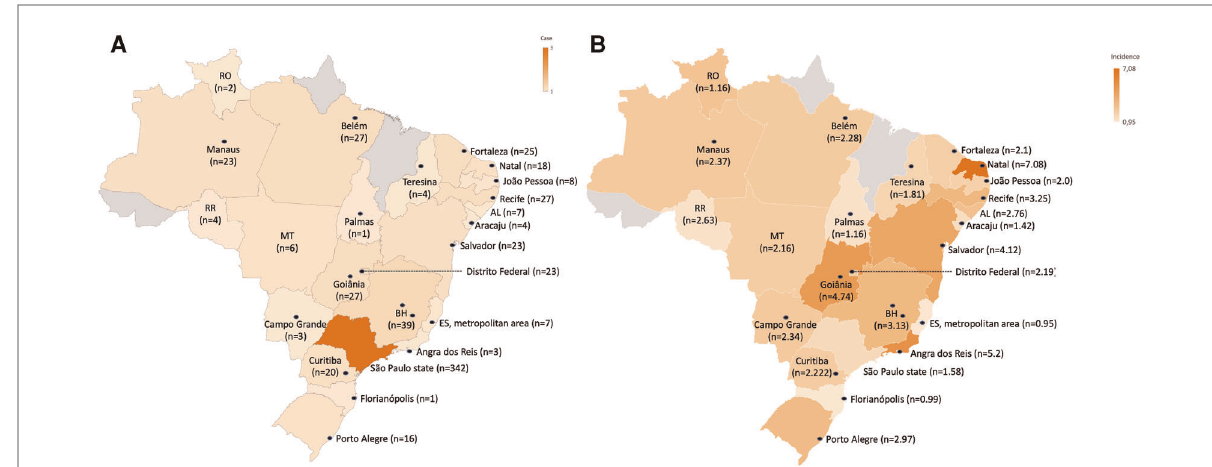
FIGURE 2 Number of retinoblastoma cases (0 – 19 years of age) incident in the fi ve Brazilian geographic regions, according to the Population-Based Cancer Registry of the National Cancer Institute, Ministry of Health of Brazil. Northern Region: RO (Rondônia state), RR (Roraima state) and cities of Manaus (Amazonas state), Belém and Ananindêua (Pará state) and Palmas (Tocantins state). Northeast Region: AL (state of Alagoas) and cities of Fortaleza (state of Ceará), Natal (state of Rio Grande do Norte), João Pessoa (state of Paraíba), Recife (state of Pernambuco), Aracaju (state of Sergipe), Teresina (state of Piauí) and Salvador (state of Bahia). Midwest Region: MT (state of Mato Grosso) and cities of Goiânia (state of Goiás), Campo Grande (state of Mato Grosso do Sul) and Brasília (Federal District). Southeast Region: cities of São Paulo, Barretos, Campinas and Jahu (state of São Paulo); Belo Horizonte (state of Minas Gerais); Espírito Santo state metropolitan region (cities of Cariacica, Guarapari, Serra, Viana, Vila Velha, Vitória and Fundão); Angra dos Reis (state of Rio de Janeiro). South Region: cities of Curitiba (state of Paraná), Florianópolis (state of Santa Catarina) and Porto Alegre (state of Rio Grande do